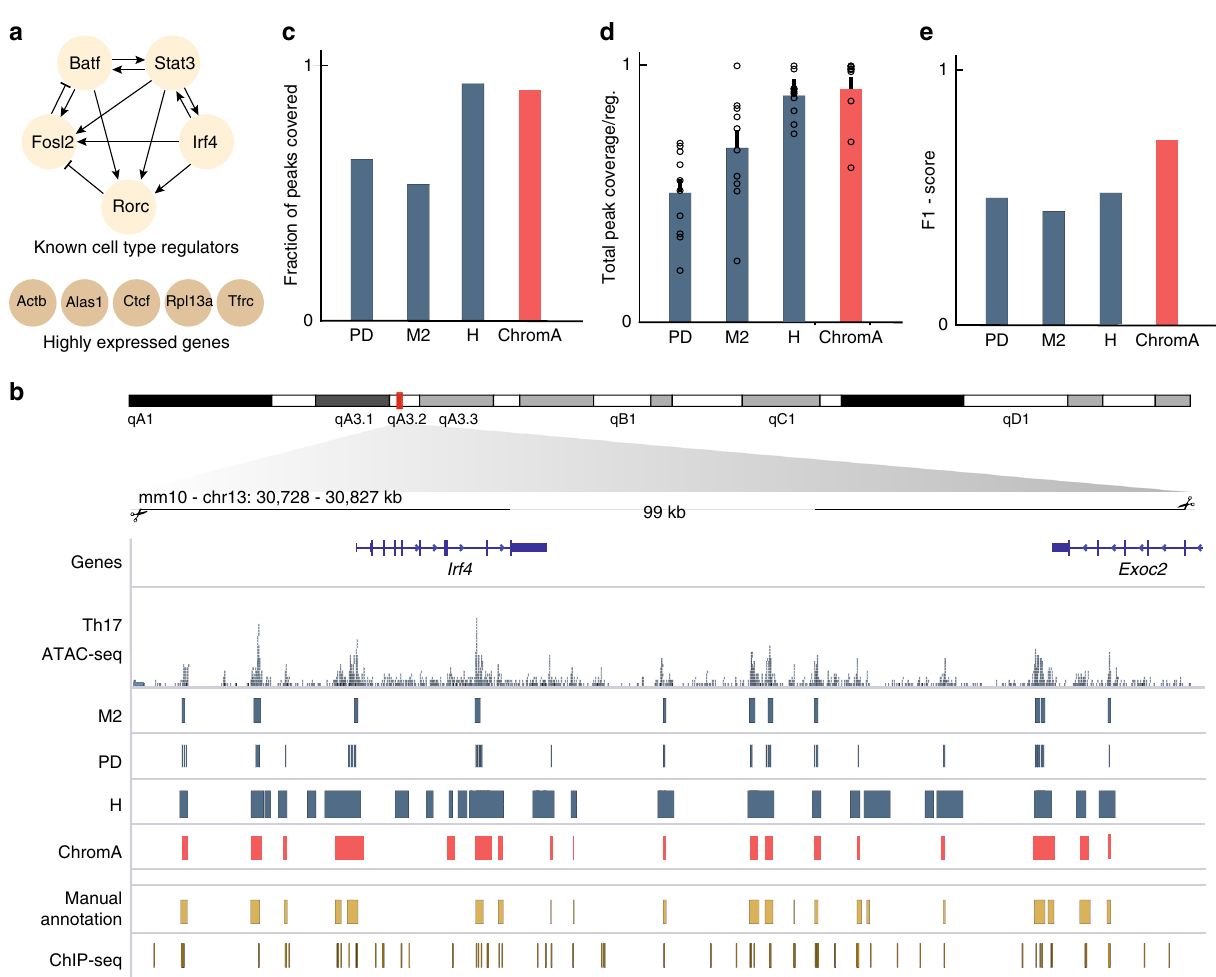
Fig. 2 Validation of ChromA on ground-truth data sets. a Genomic loci were selected to create a validation data set from highly expressed and transcription factor genes regulating Th17 development. To manually curate genomic regions, information from ChIP-seq and ATAC-seq experiments were combined. b Example of curated genomic locus fl anking the Irf4 gene in the mouse genome. ATAC-seq, ChIP-seq, PeaKDEck (PD), MACS2 (M2), ChromA, and manual annotations are displayed. ChromA algorithm recovers a greater number of ground-truth peaks than competing algorithms and covers each peak more thoroughly. c Fraction of manually annotated peaks covered with at least one peak. d Average fraction of peaks covered per genomic loci (mean + / − s.e.m., the number of regions equals 10). e F1